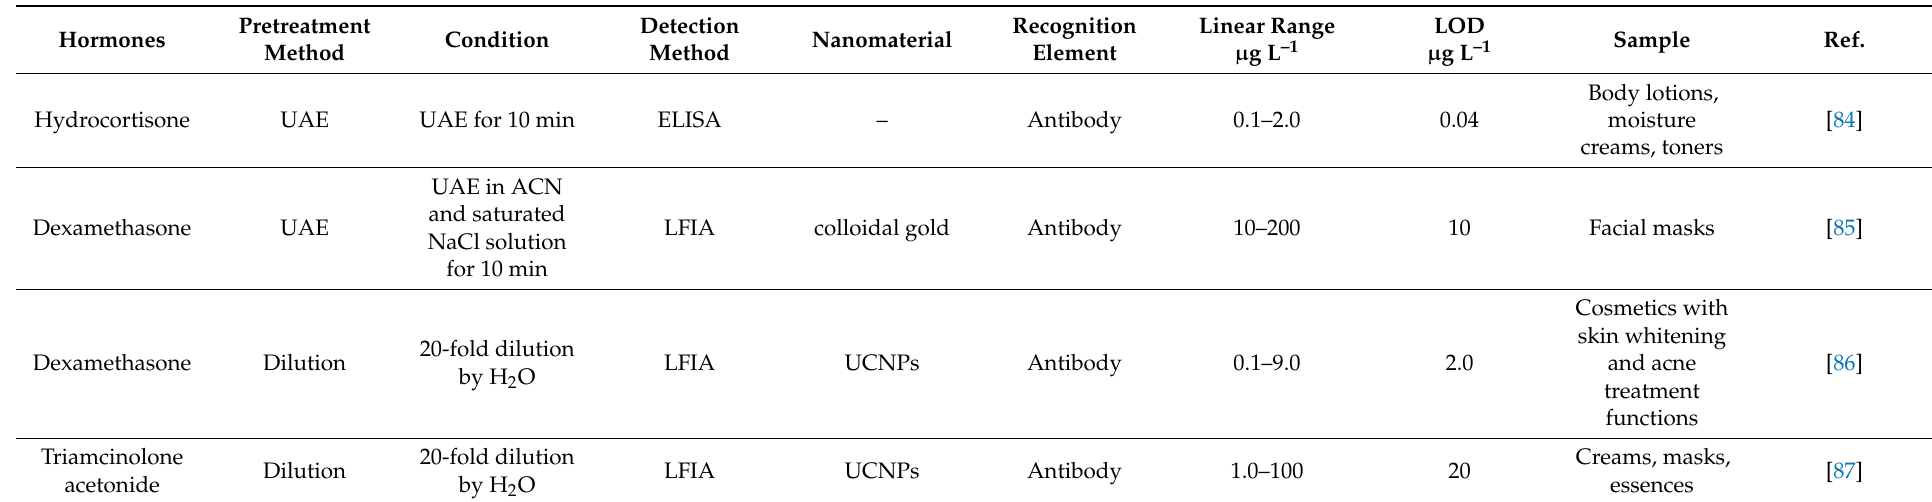
Table 3. Rapid analytical technologies for hormone determination in